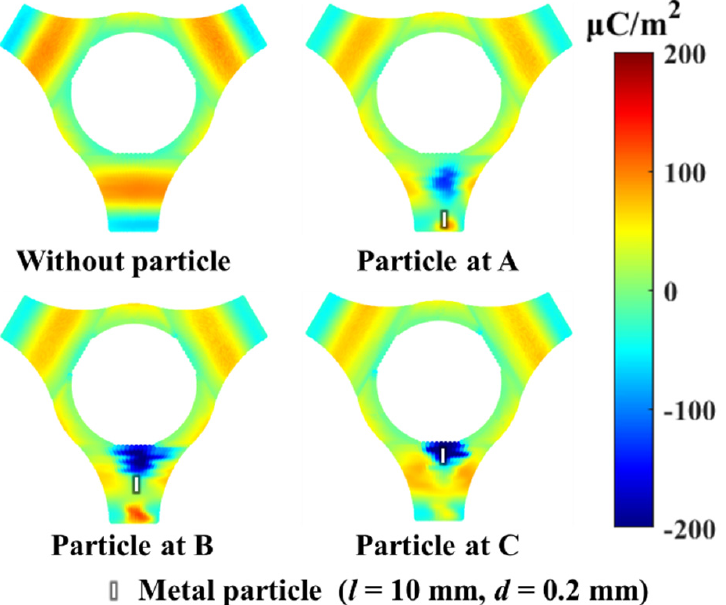
Figure 3. Surface charge distribution of tri–post epoxy insulator with metal particle attached under +100 kV DC voltage.